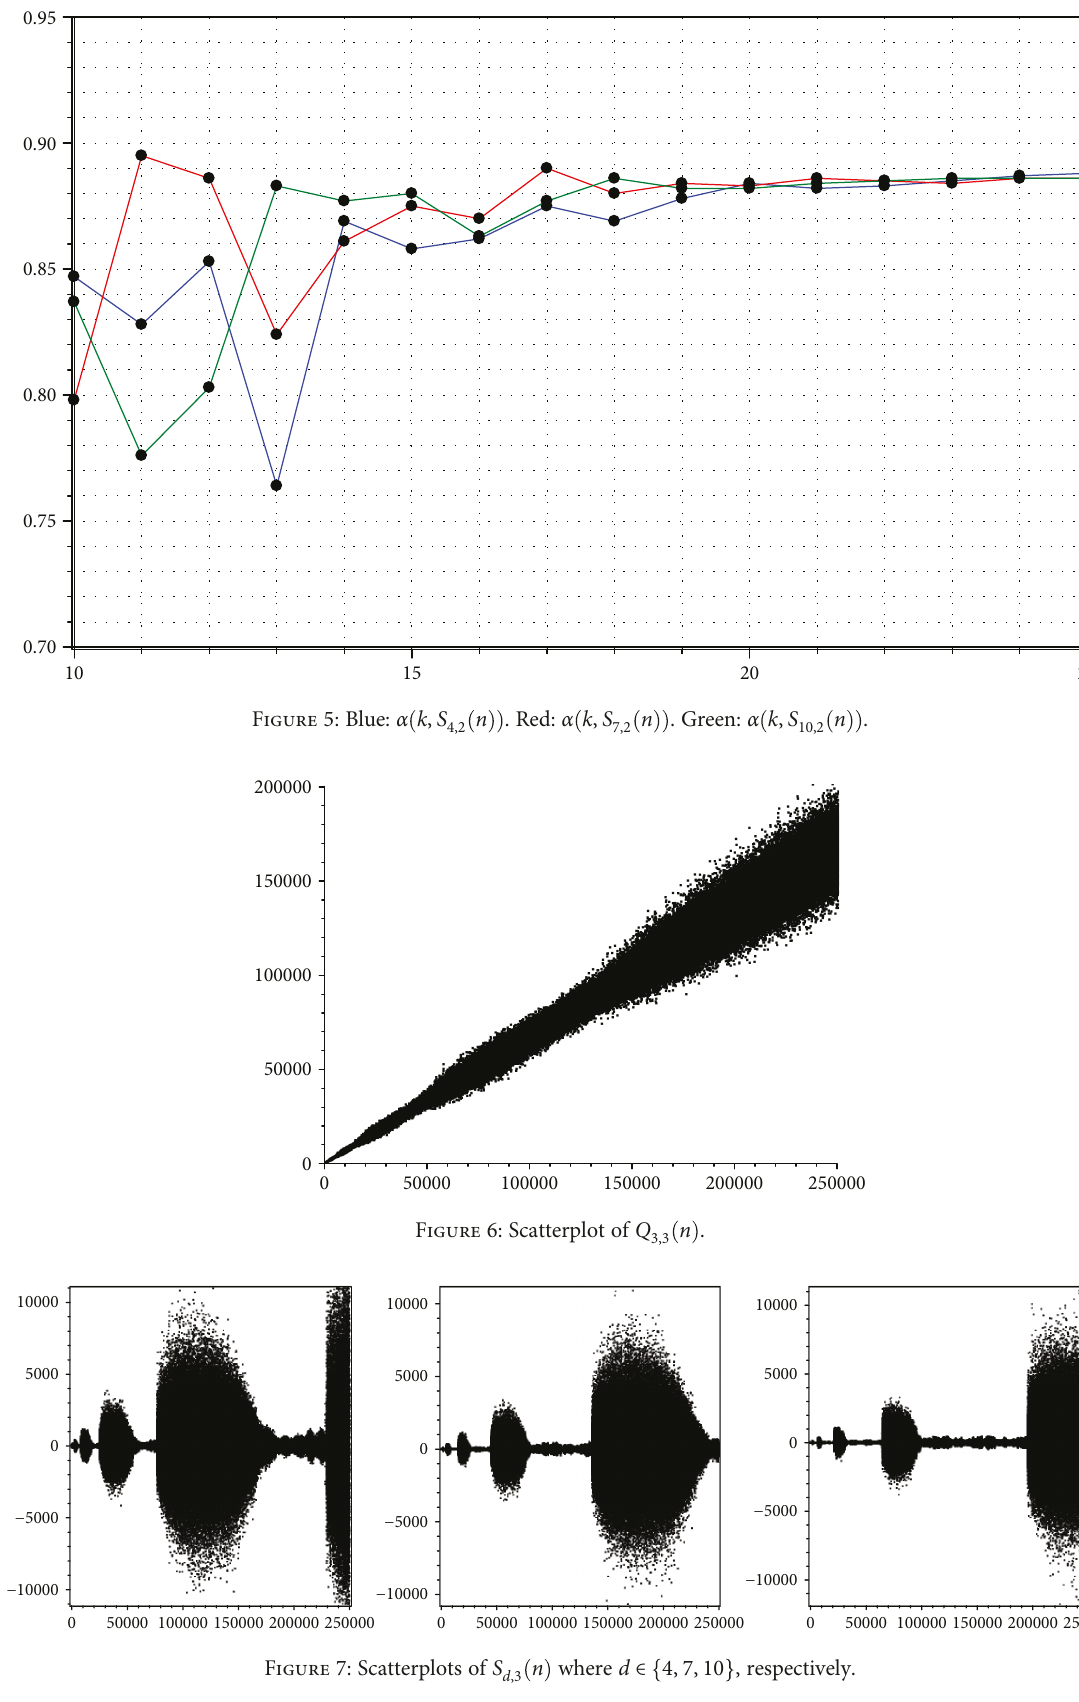
n where d ∈ 4, 7, 10 , d ,3